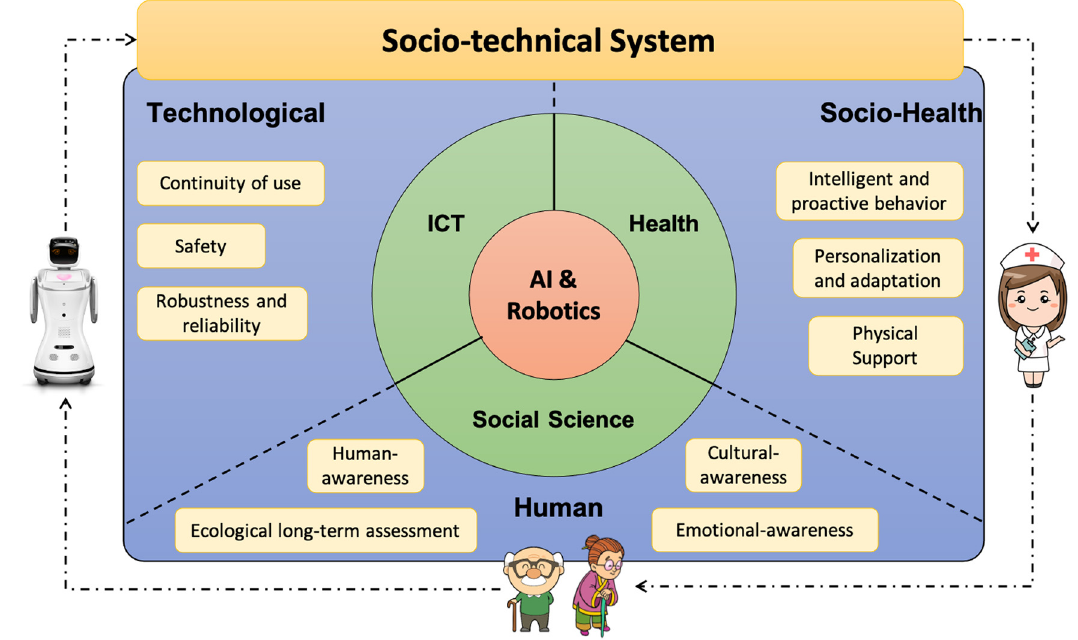
Figure 7: Multidisciplinary approach to robotic